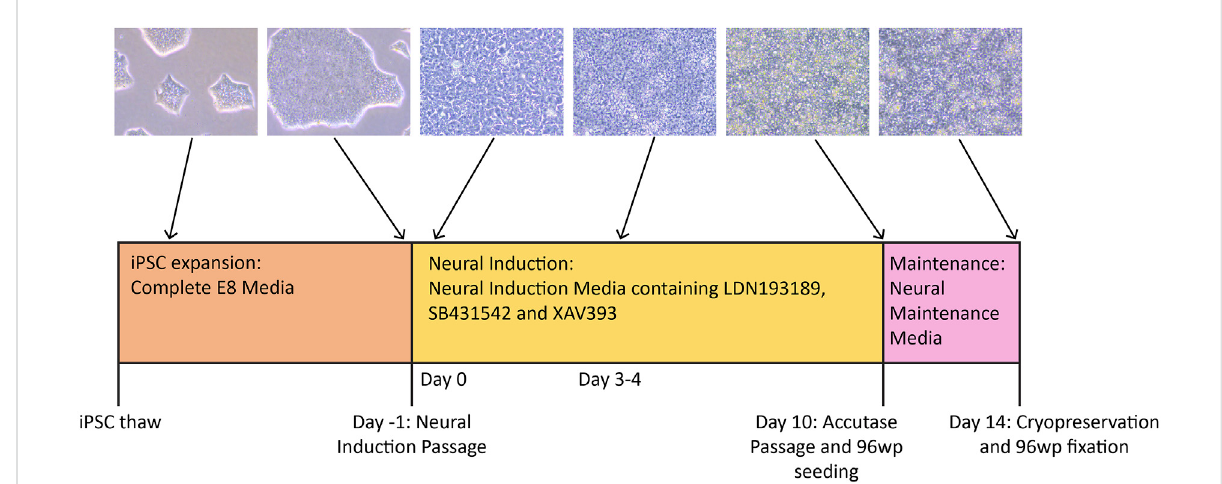
FIGURE 1 Timeline of the neural differentiation protocol. iPSCs are thawed in Complete E8 media, then expanded to the desired number of wells before the Neural Induction passage (Day -1). On Day 0, the medium is switched to NIM (Neural Induction Media). Media change with NIM takes place daily until Day 10, when the cells are passaged with accutase and simultaneously plated to 96-well plates for immunocytochemistry. By Day 10, the cells should have neural stem cell identity. During this passage, the cells are re-plated in NMM (Neural Maintenance Media) on both plate types. The cells grow in NMM until Day 14, with media change taking place every other day. On Day 14, the cells are cryopreserved in NMM +10% DMSO, and those growing on the 96-well plates are fi xed in preparation for antibody staining.